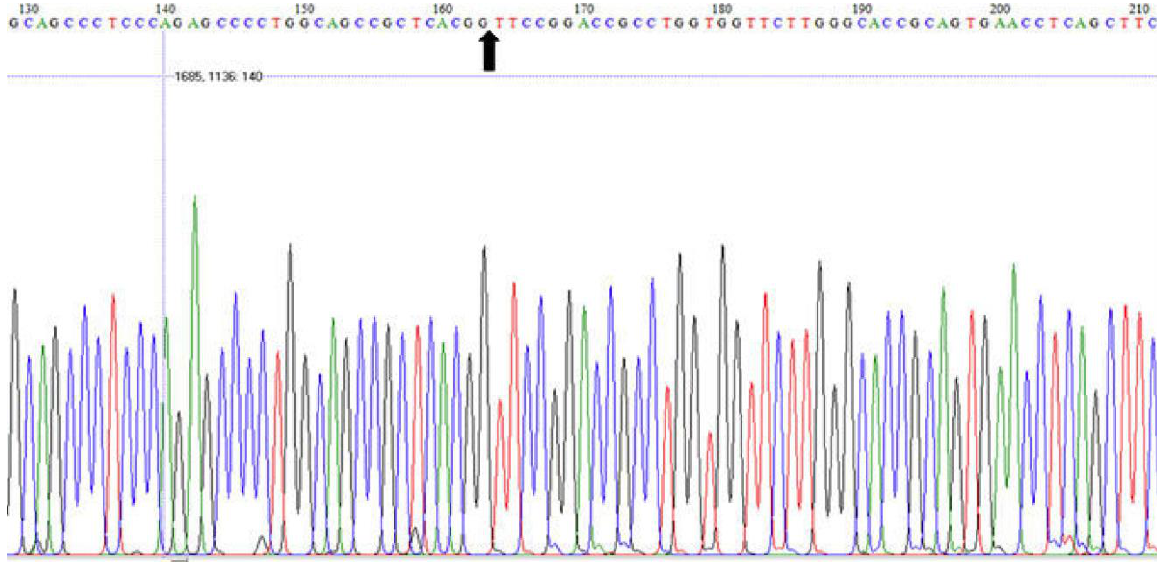
Figure 2: Partial DNA sequencing chromatograms of ABO gene of A 2 –related alleles identified by direct sequencing. The arrow indicated the deletion of 1061C nucleotide at rs 8176750 of Sample 2.